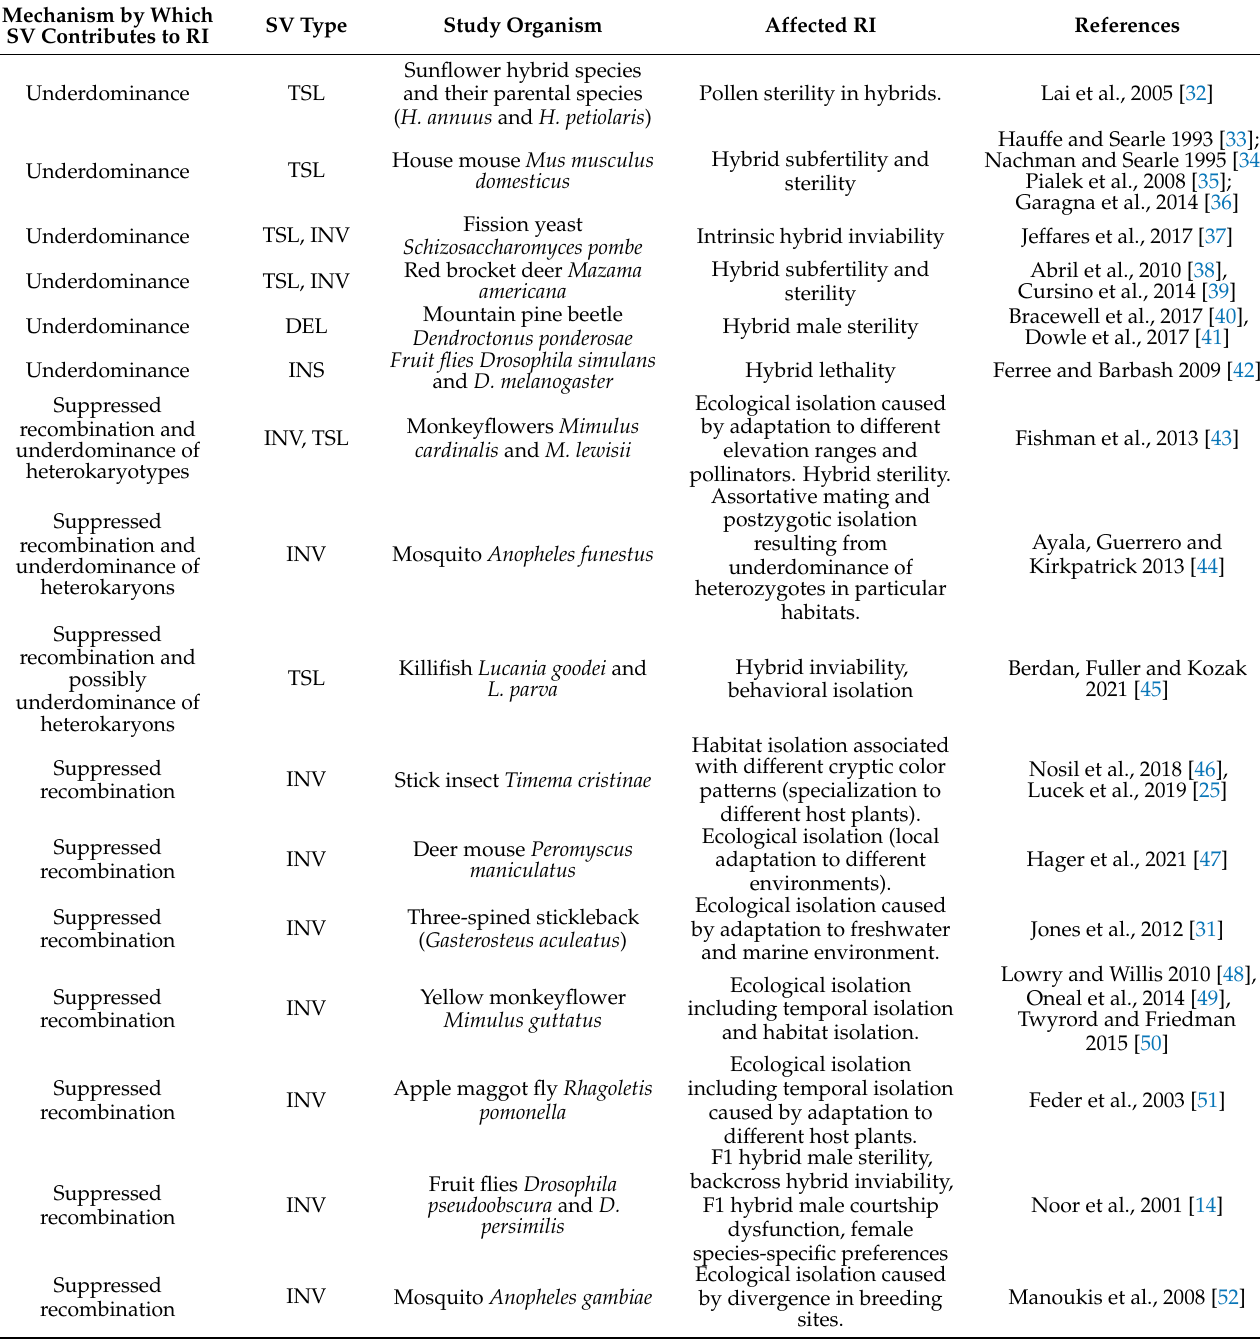
Table 1. List of studies that identified structural variants involved in reproductive